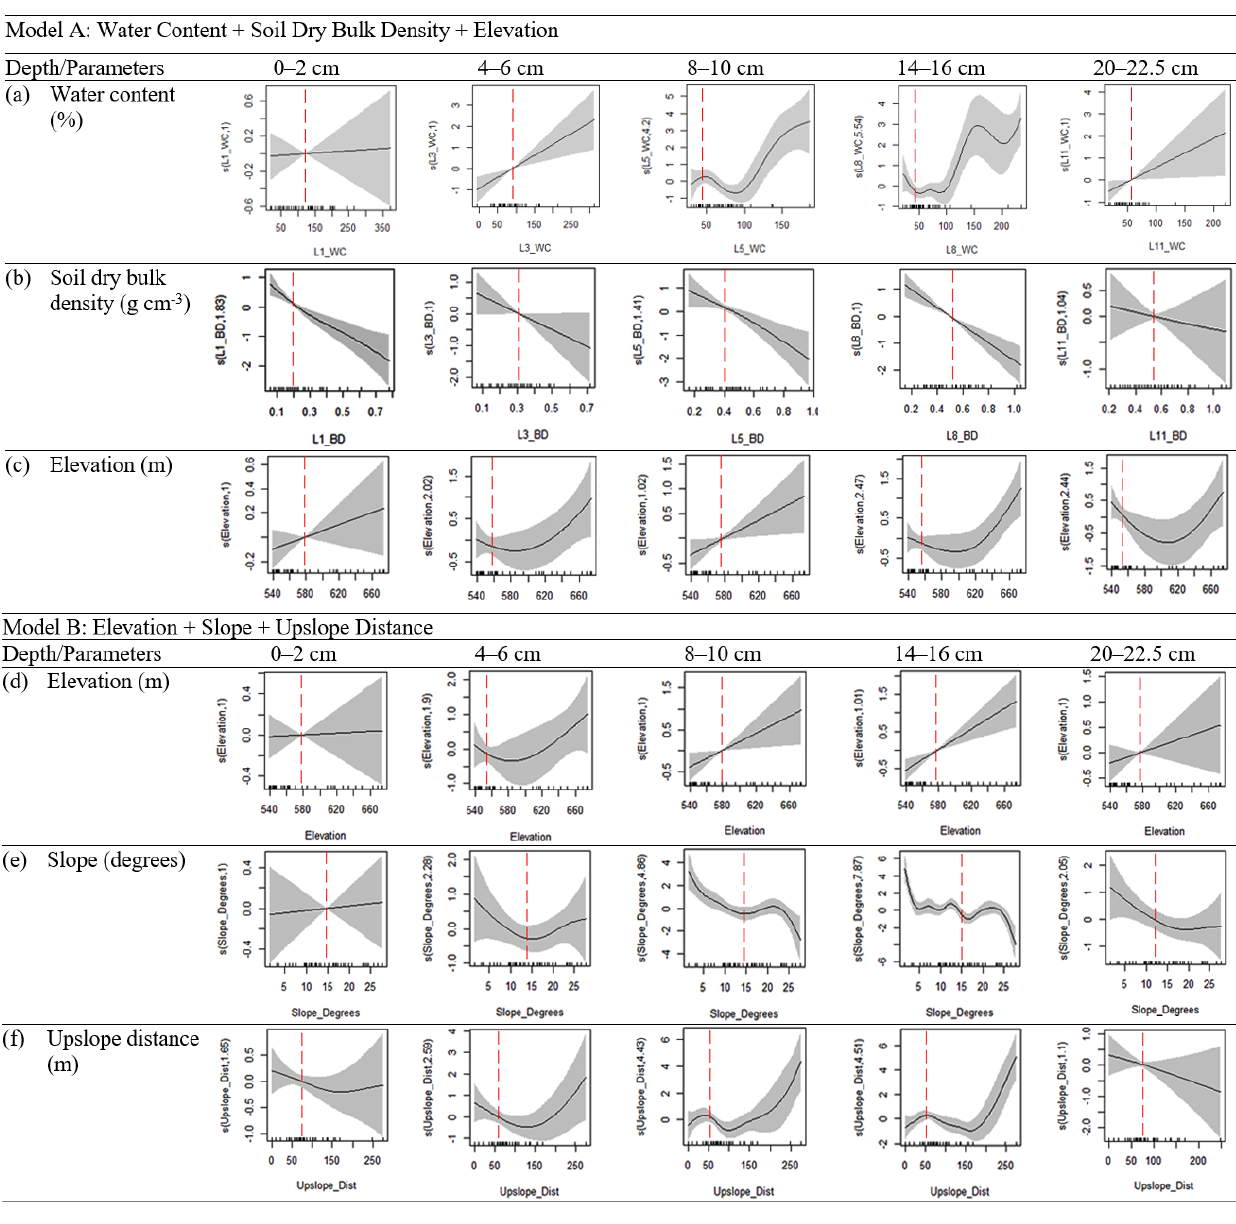
Figure 13. GAM smooth function outputs at five depth layers for the parameters in the two best-performing models. The x axis on each plot is the model predictor and its real value range. The y axis is the smoothing parameter, s(covariate, degree of freedom). Vertical dashed red lines indicate a point at which the smoothing parameter is the zero residual